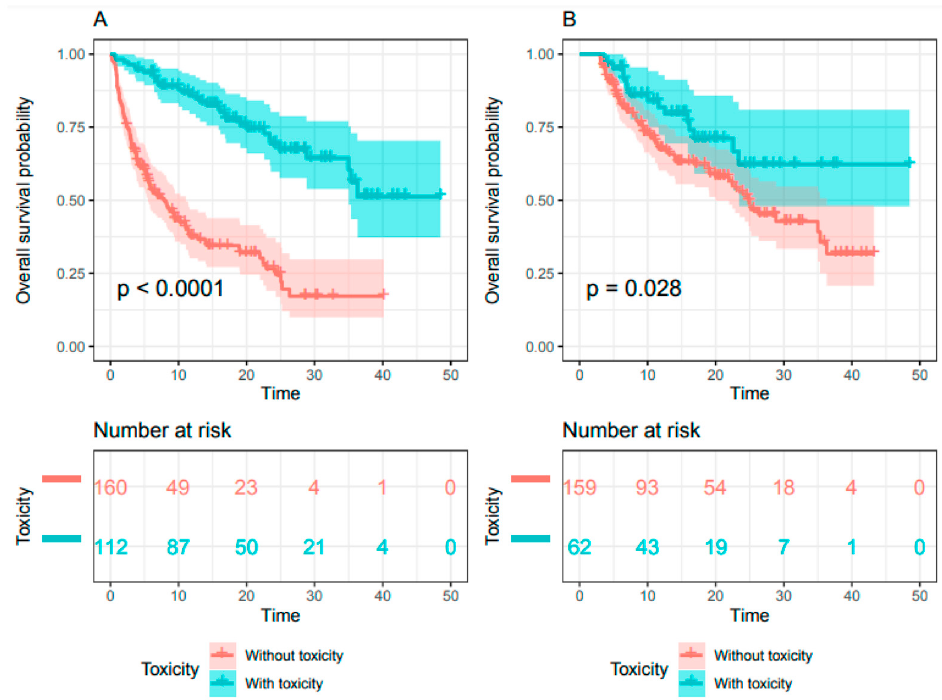
Figure 4. Kaplan–Meier estimate of overall survival for ( A ) the whole population and ( B ) the three-month toxicity landmark ( n = 272) .